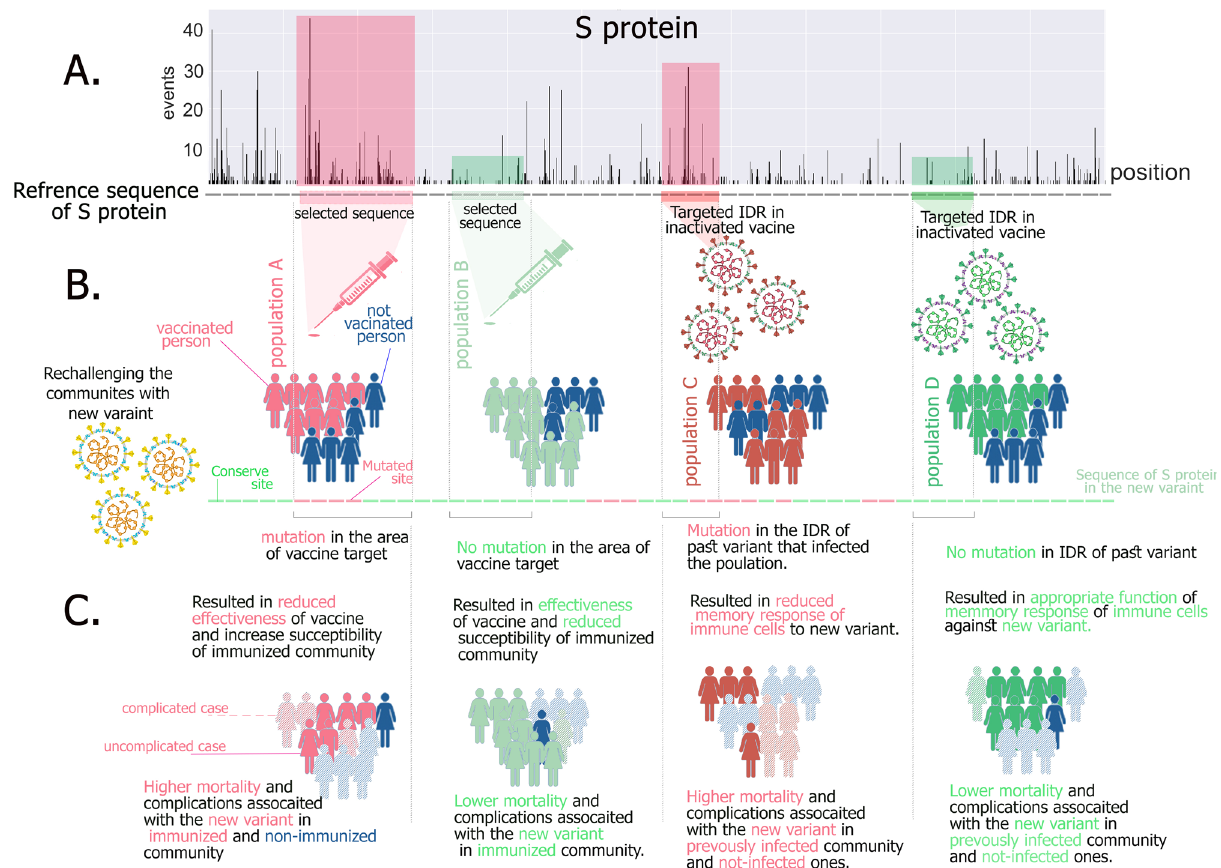
Figure 3. Different population with different exposure and vaccination. Panel ( A ) presents a mutational diagram of S protein with conserved and mutated sites and areas as demonstrated before. In panel ( B ) a schematic view of the S protein sequence with mutations and different regions with the qualitative view is illustrated. Different populations with varying types of immunization from various parts of the S protein sequence are presented. In panel ( C ), a rechallenge of all communities with a new variant is shown and the outcome of different sites of S protein that had been used for immunization is illustrated schematically. Blue dummies in the figure represent the not vaccinated population and the pale ones represent dead people in the community. Painted dummies in all colors except dark blue represent past infection or